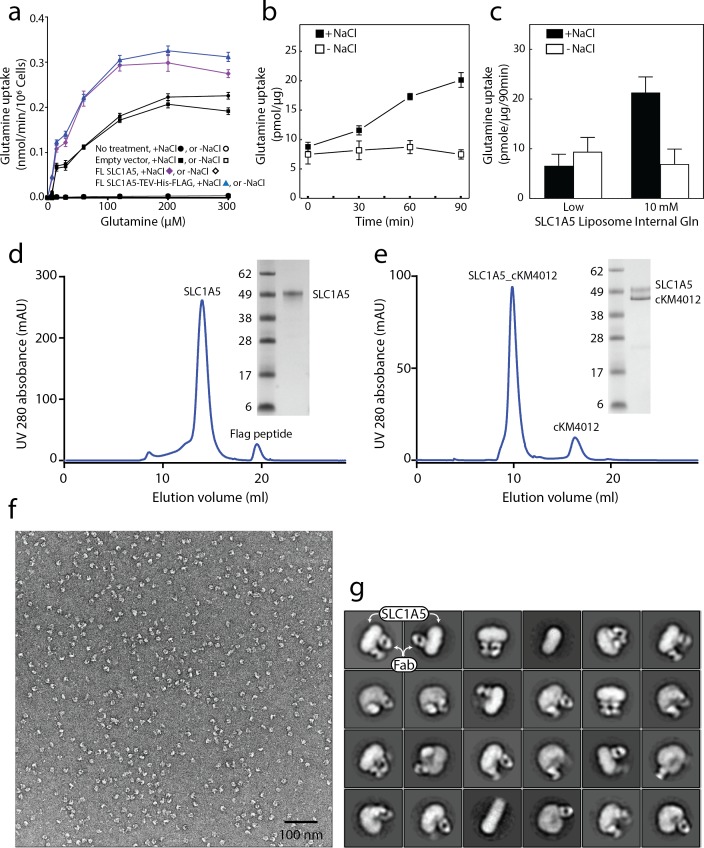
SLC1A5 protein purification, functional assays in cells and proteoliposomes and negative staining.(a) Uptake of [14C]-glutamine in HAP1 SLC1A5KO cells or SLC1A5KO cells transiently transfected with pcDNA3 vector containing the indicated sequence in the presence (solid bar) or absence (open bar) of sodium chloride. (b), (c) Uptake of [3H]-L-glutamine by purified SLC1A5 reconstituted in proteoliposomes. Transport was started by the addition of 50 μM L-glutamine/[3H]-L-glutamine (100 dpm/pmole) to SLC1A5 proteoliposomes in the presence (▪) or absence (□) of 100 mM external sodium chloride. (b) Internal proteoliposome buffer contained 10 mM glutamine and uptake was measured at the indicated times. The experiment was performed with triplicates at each time point; error bars represent standard deviation. (c) Internal buffer contained either low internal glutamine (0 mM or 0.1 mM) or 10 mM glutamine and uptake was measured at 90 min. The graphs are means of three independent experiments performed in triplicate. Error bars represent the s.e.m. Similarly prepared SLC1A5 in proteoliposomes showed [3H]-glutamine efflux in the presence of external (assay buffer) glutamate and NaCl (Oppedisano et al., 2007). (d), (e) Size-exclusion chromatography (Superose 6 10/300 Increase filtration column) of SLC1A5 and its complex with cKM4012 (Fab). The peak fraction was examined by SDS-polyacrylamide gel electrophoresis (SDS-PAGE). (f) Raw micrograph of SLC1A5-cKM4012 (Fab) complex by negative-stain electron microscopy. (g) 2D-class averages of particles from negative-stain electron microscopy of SLC1A5-cKM4012 (Fab) complex. Signals corresponding to the SLC1A5 and Fabs are highlighted.